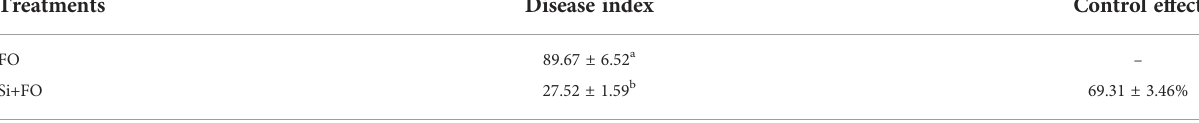
TABLE 3 Control effect of exogenous silicon on Fusarium wilt in cucumber plants.